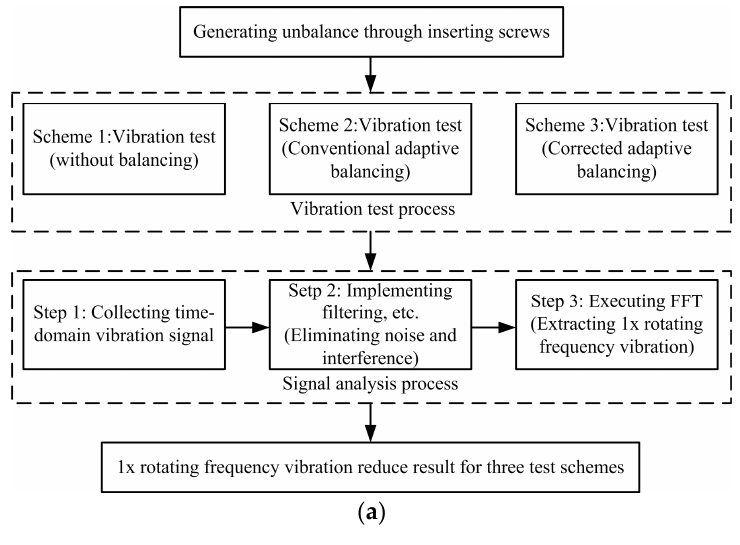
Table 5. Unbalanced mass and its position used for the balancing